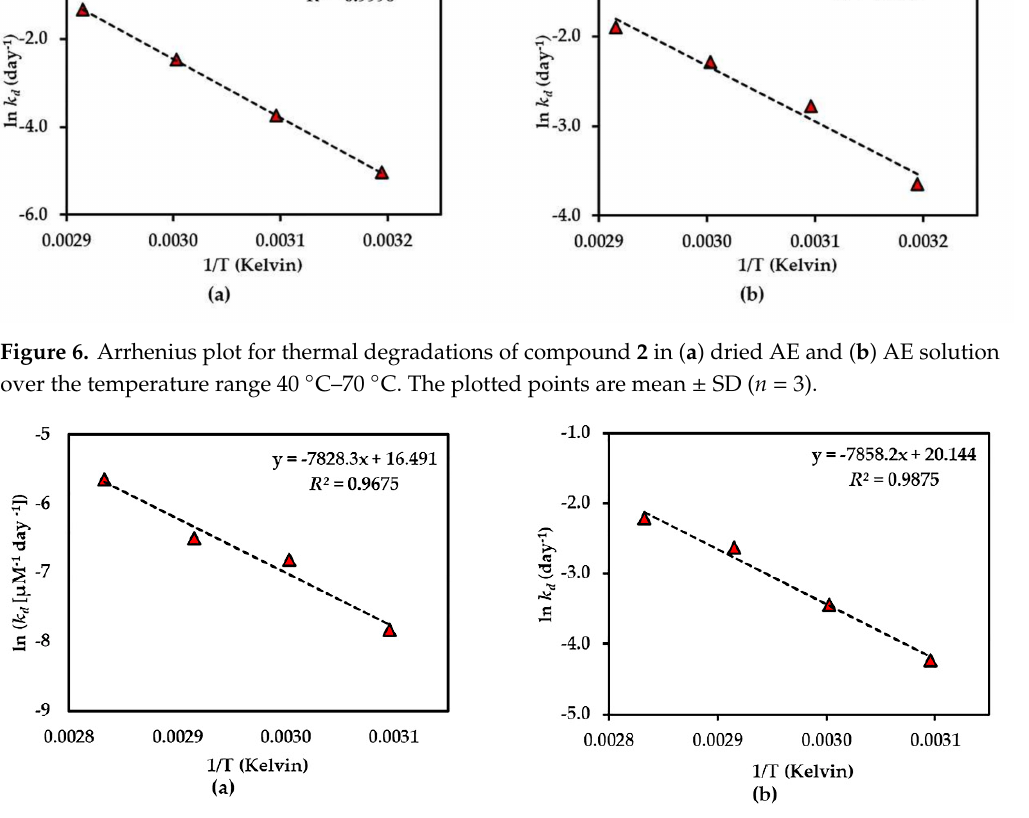
Figure 7. Arrhenius plot for thermal degradations of compound 3 in ( a ) dried AE and ( b ) AE solution over the temperature range 50 °C–80 °C. The plotted points are mean ± SD ( n = 3).